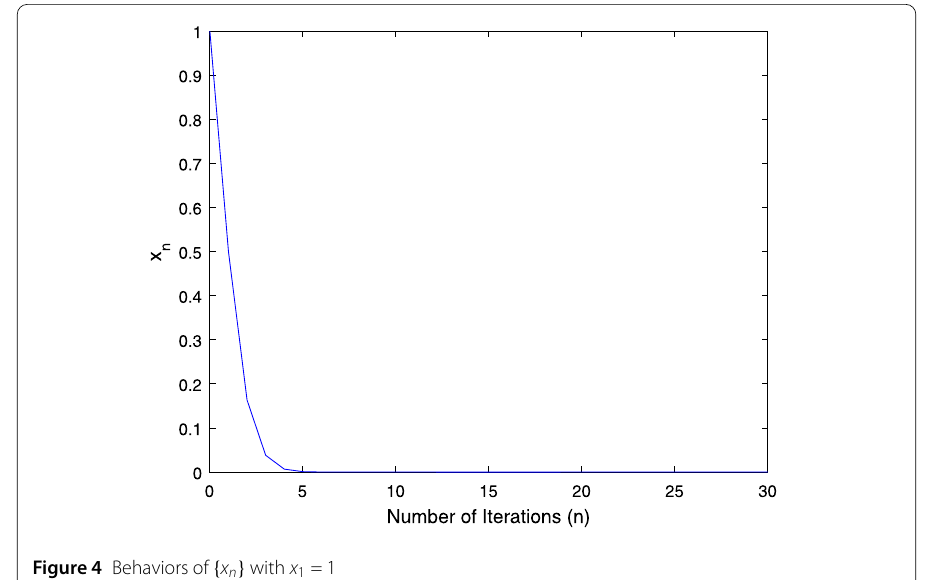
Figure 4 Behaviors of { x n } with x 1 =